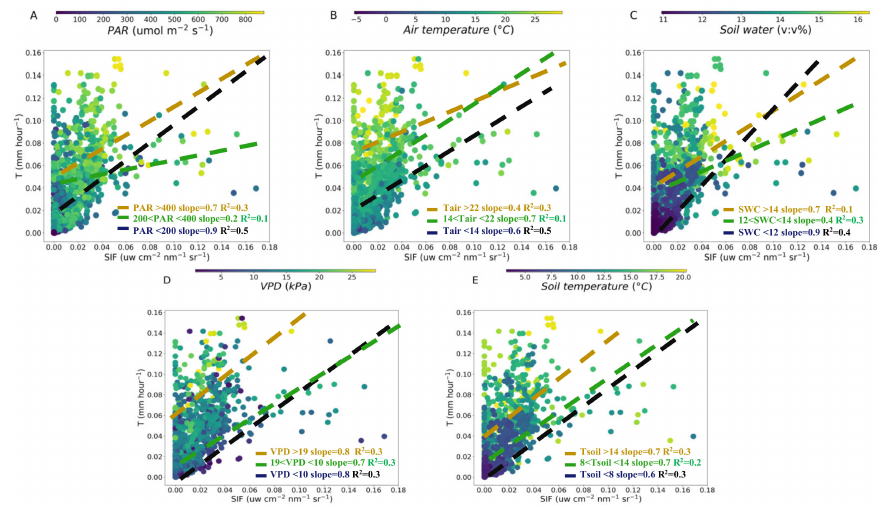
Figure 4. Relationship between SIF and T over PAR ( A ), air temperature ( B ), soil water content ( C ), VPD ( D ) and soil temperature ( E ) at hourly scale. The dashed lines are linear regression fitted to the SIF and T for different variables value interval: the lowest (black, <33%), medium (green, 33%–66%) and highest (yellow, >66%) at hourly scale, respectively.